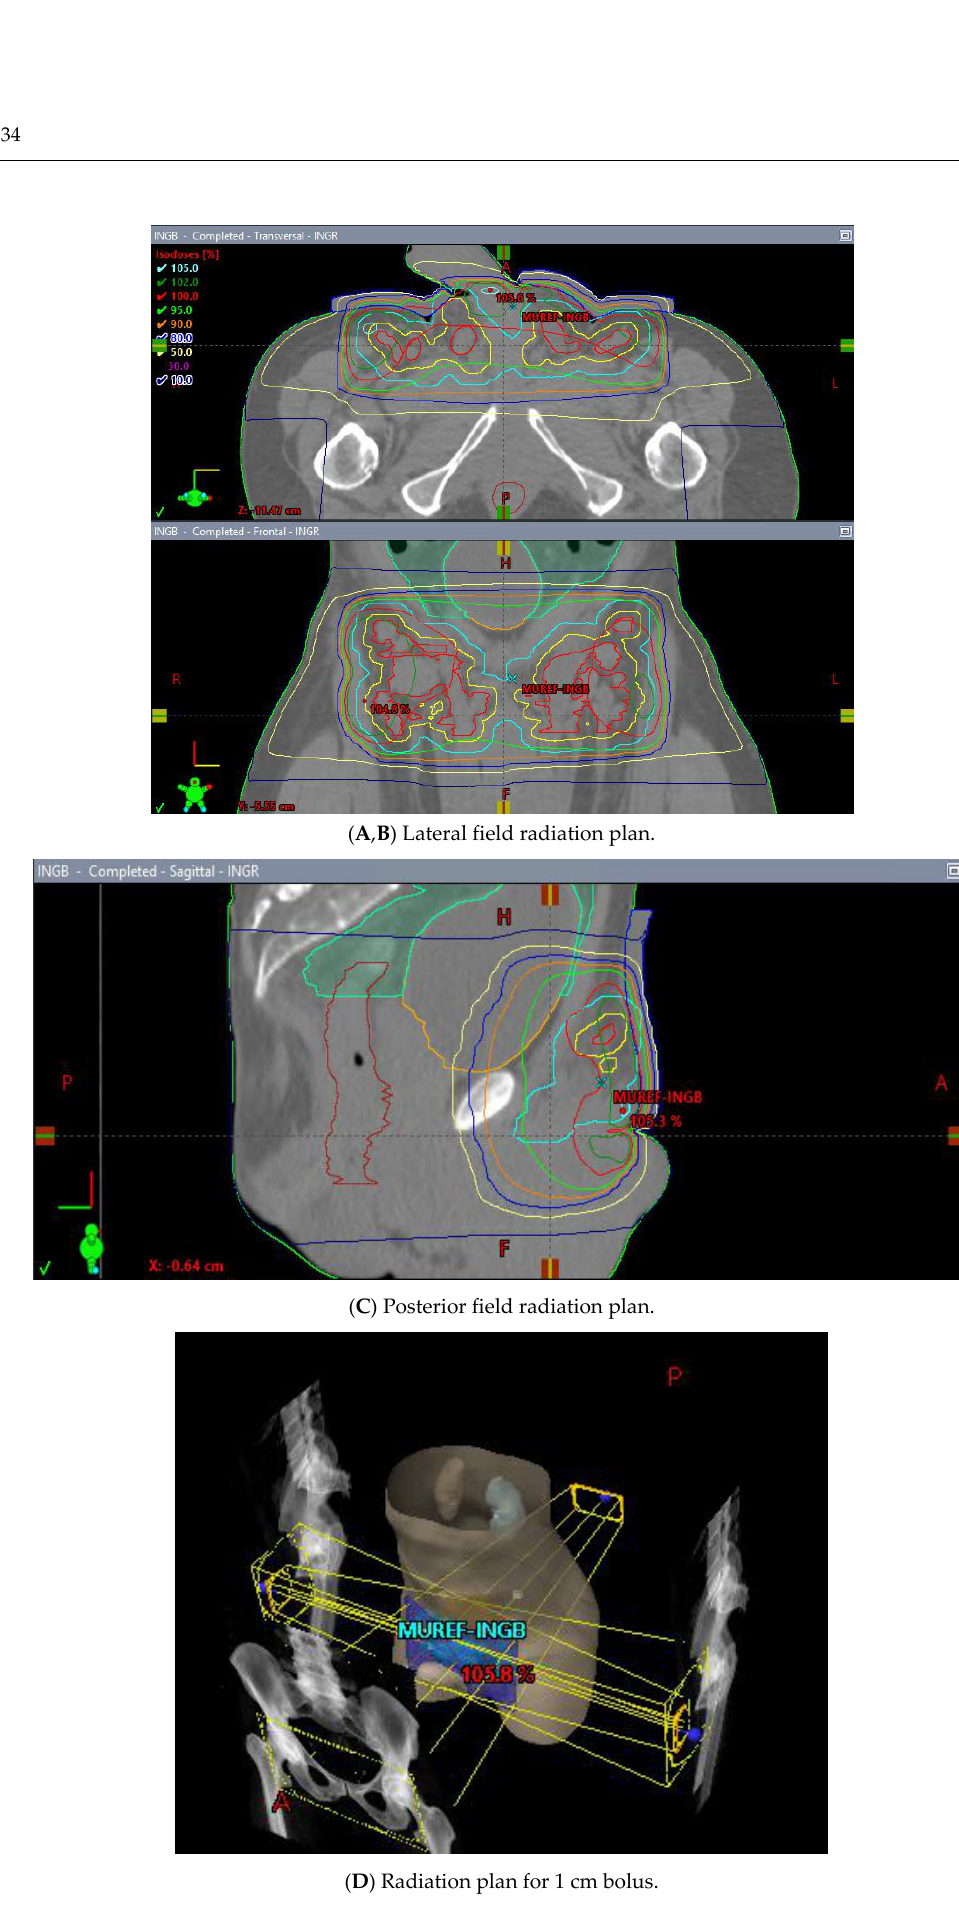
Figure 10. 3 Field (2 laterals ( A , B ) and 1 posterior ( C ) field) palliative radiation plan with 20 Gy/5 fractions to the inguinal nodes with a 1 cm bolus ( D ). Despite palliative chemotherapy and palliative radiation, the patient’s clinical status continued to deteriorate. He developed worsening lethargy, poor intake, renal failure, and open penile and scrotal sores with purulent drainage, indicative of a superimposed infec- tion, and he was re-admitted for further management. Imaging showed the significant further progression of metastatic disease (Figure 7 – 9), especially in the pelvis, with new bilateral hydroureteronephrosis and evidence of ileus. He was deemed to no longer be a candidate for further radiation or systemic therapy because of his declining clinical con- dition. The urology staff again recommended against the resection of the scrotum and penis. He elected to pursue comfort measures only and died in hospital.